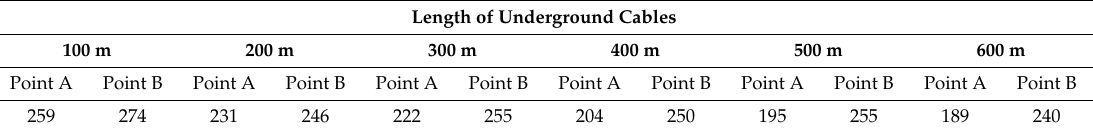
Table 6. Maximum overvoltage (kV) at points A and B, where the current of the lightning strike to point A is 40 kA.